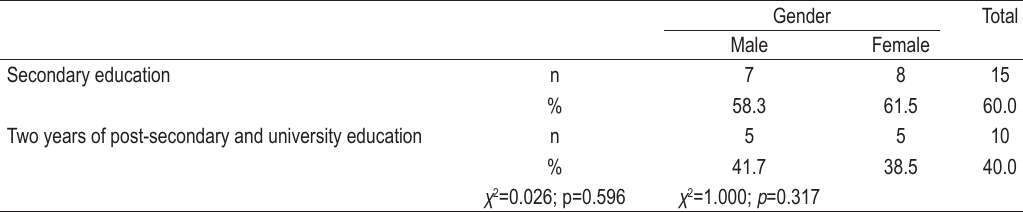
TABLE 2. Educational profile of respondents